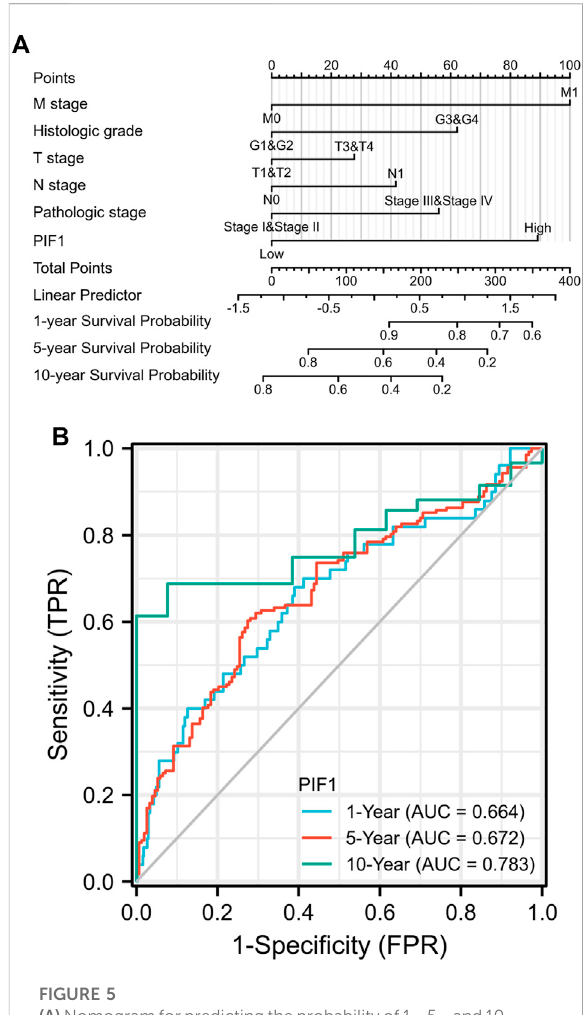
FIGURE 5 (A) Nomogramforpredictingtheprobabilityof1-,5-,and10- year OS for ccRCC patients. (B) The ROC curve analysis also showedthatPIF1wasassociatedwithAUCvaluesof0.664(1